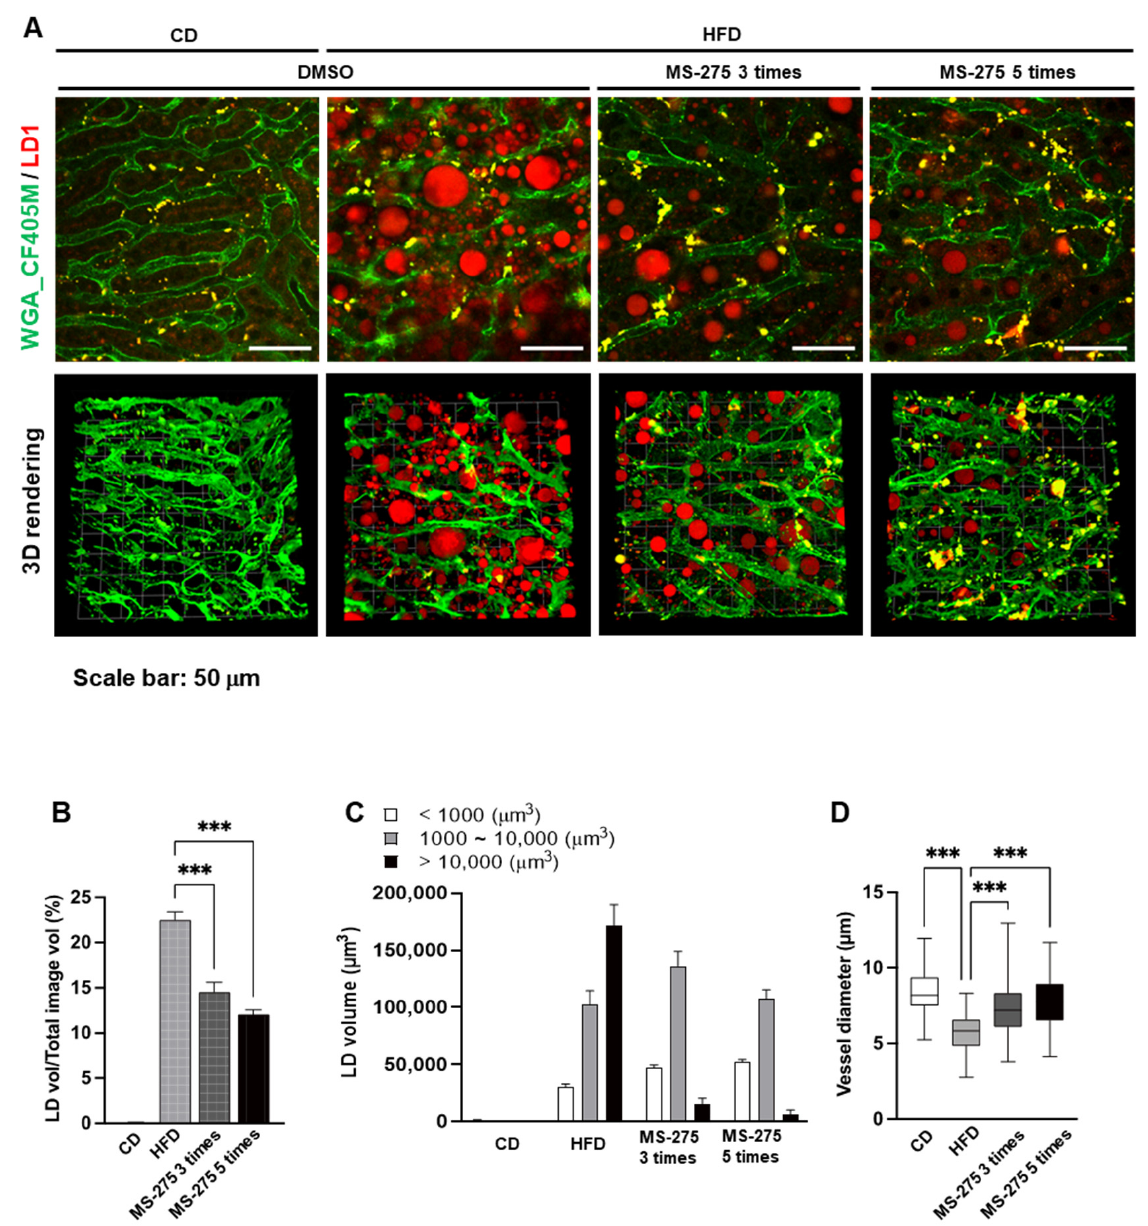
Figure 3. MS-275 stimulated degradation of hepatic LDs in HFD-induced fatty liver. DMSO or MS- 275 treated mice were intravenously injected with WGA antibody (green) to stain blood vessels, and LD1 (red) to stain LDs. ( A ) Hepatic LDs and blood vessels were visualized by intravital two-photon imaging and 3D rendering using a two-photon microscope in 0, 3, and 5 times of MS-275 injection; ( B ) LD accumulation was quantified based on the LD volume; ( C ) LD volumes were classified as <1000, 1000–10,000, or >10,000 µ m 3 ; ( D ) Hepatic sinusoidal vessels were quantified based on vessel diameter. *** p < 0.001 (one-way ANOVA).